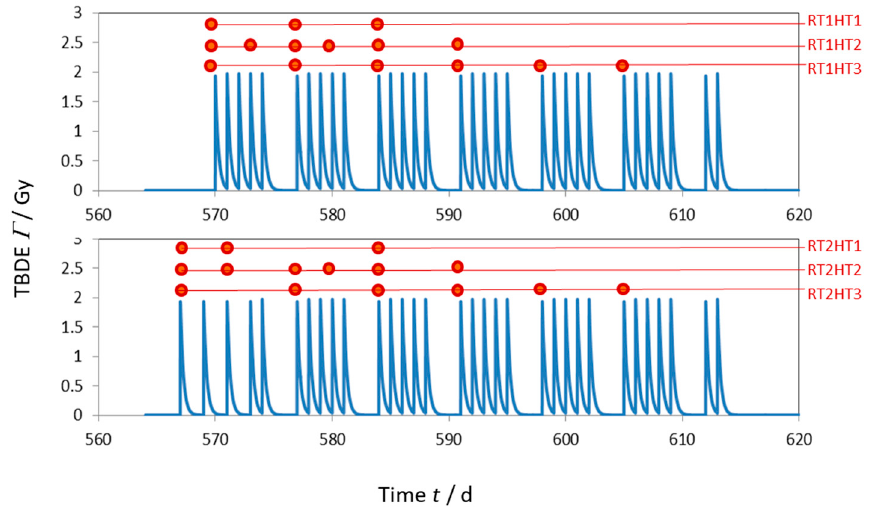
Figure 2. Different scenarios for fractionation and HT sessions: RT is applied in 32 fractions with 2 Gy per fraction, The HT scheme in RTxHT2 corresponds to the HYCAN trial [55], RTxHT3 to the KSA bladder trial [56].